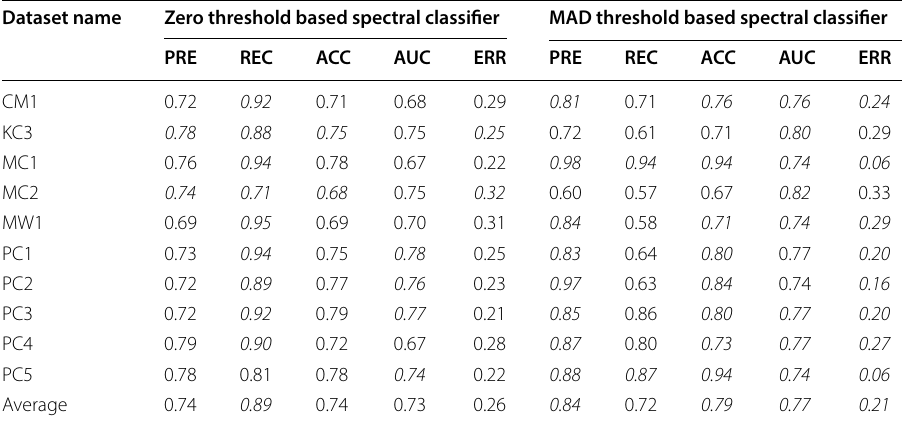
Table 5 Performance comparison between zero and MAD threshold based spectral